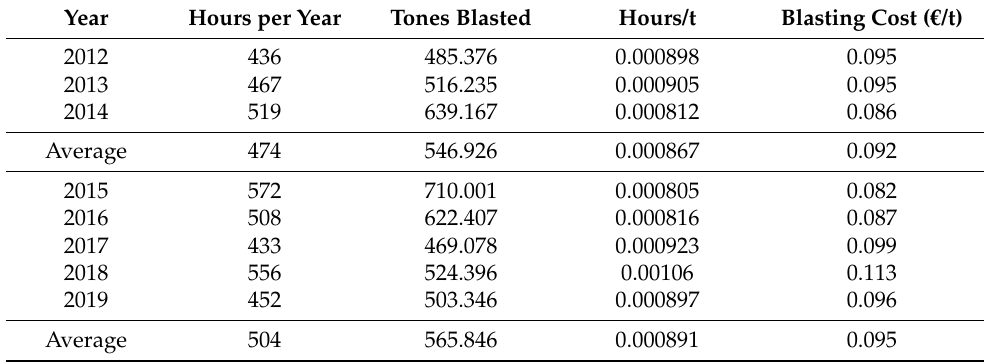
Table 10. Comparison of the initial design and its improvement over time.